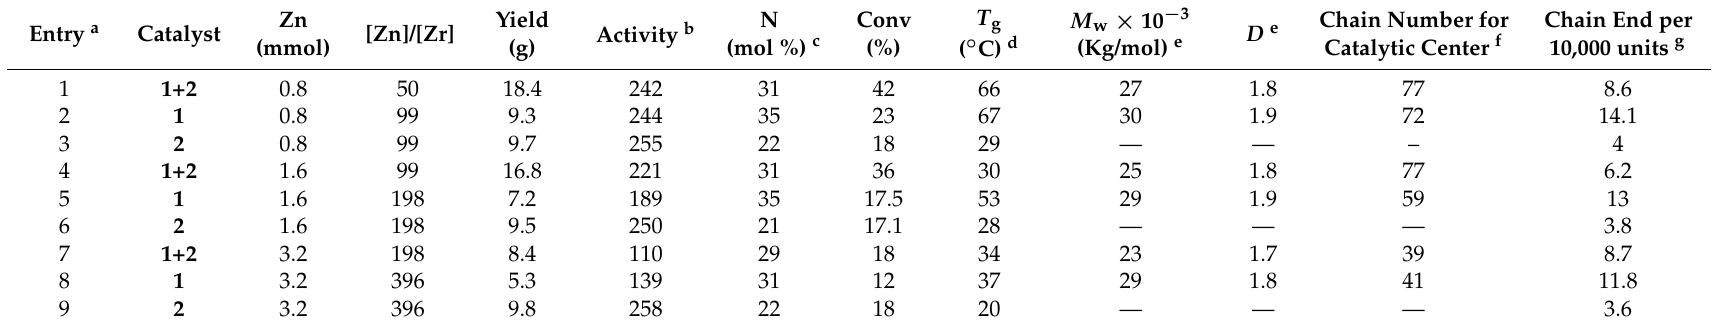
Table 1. Poly(Ethylene– co –Norbornene) using catalysts 1 and 2 in the presence of ZnEt 2 at [N]/[E] feed ratio of 1.3 and pE = 19 bar.